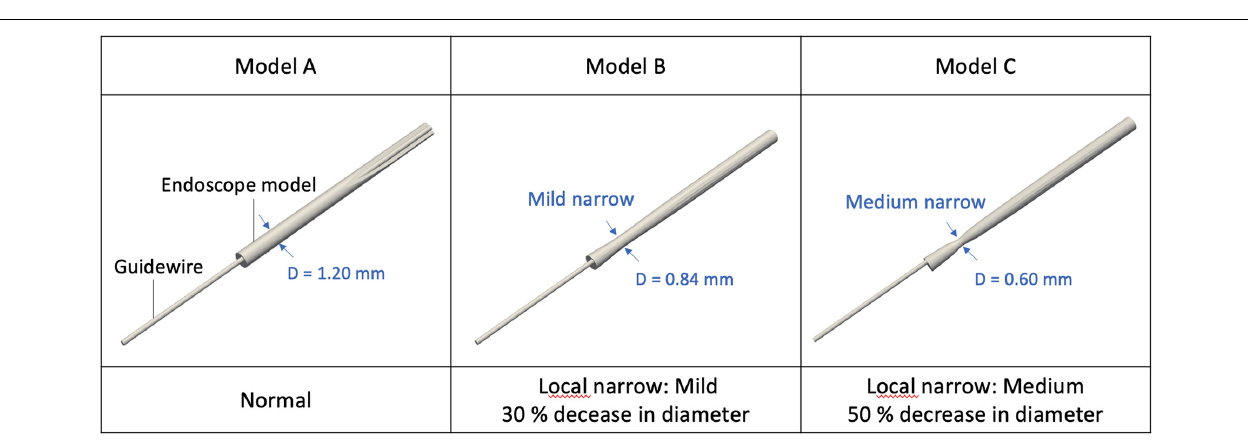
FIGURE 2 | 3D simulation model of endoscope with different morphological